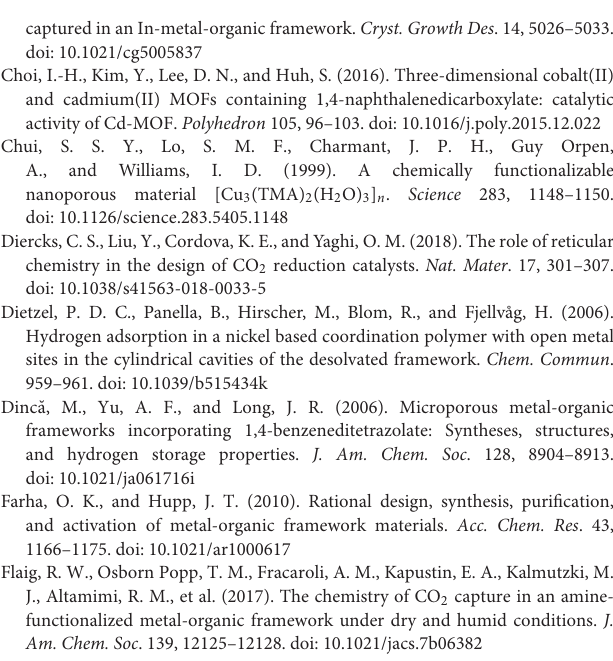
Table S3 . The isosteric heats of H 2 adsorption were estimated by virial method as given in Figure 7B and Figure S9 . The zero surface coverage value is − 8.79 kJ mol − 1 and this value is relatively high level compared to other known values for common MOFs (Hu and Zhang, 2010). The heats of H 2 adsorption for MOFs are known to be in the range − 3.8 ∼ −